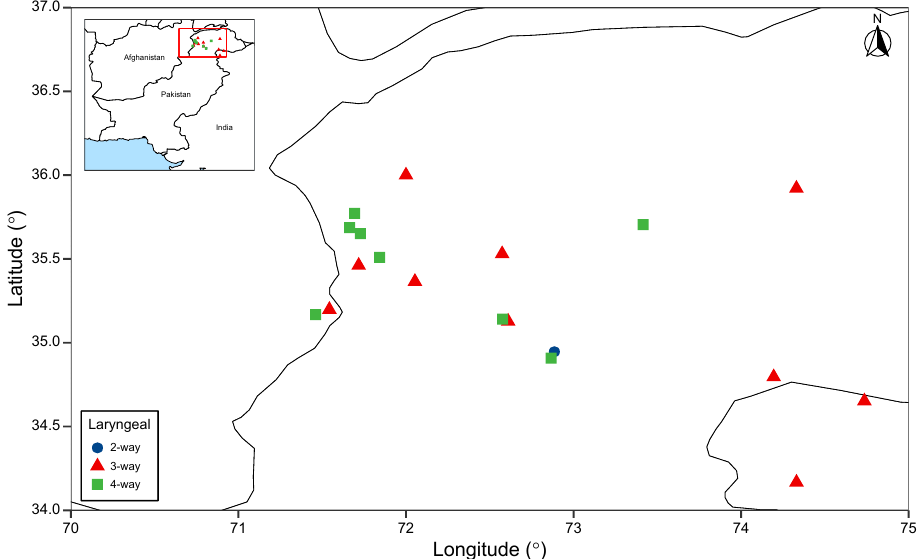
Figure 1. Map of Northwestern region of South Asia where Dardic languages are spoken. Number of laryngeal contrasts (2-, 3-, or 4-way) found in Dardic languages are